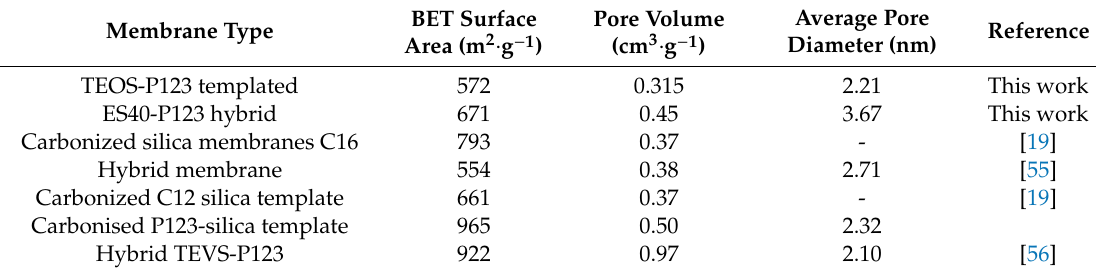
Table 1. Surface area, pore volume, and pore diameter of TEOS-P123 templated and ES40-P123 hybrid, both calcined in air at 350 ◦ C.